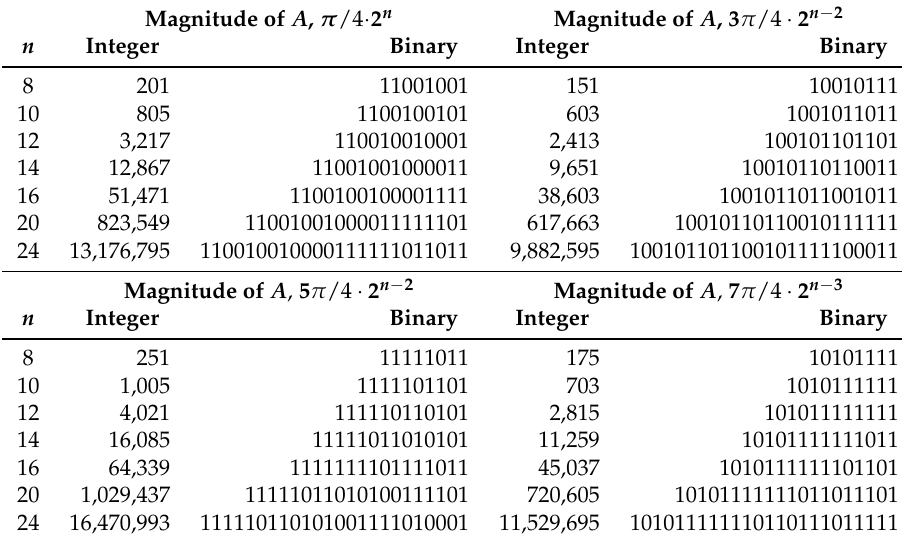
Table 2. Values of | A | used for synthesis, π /4 · 2 n , 3 π /4 · 2 n − 2 , 5 π /4 · 2 n − 2 and 7 π /4 · 2 n − 3 rounded to nearest